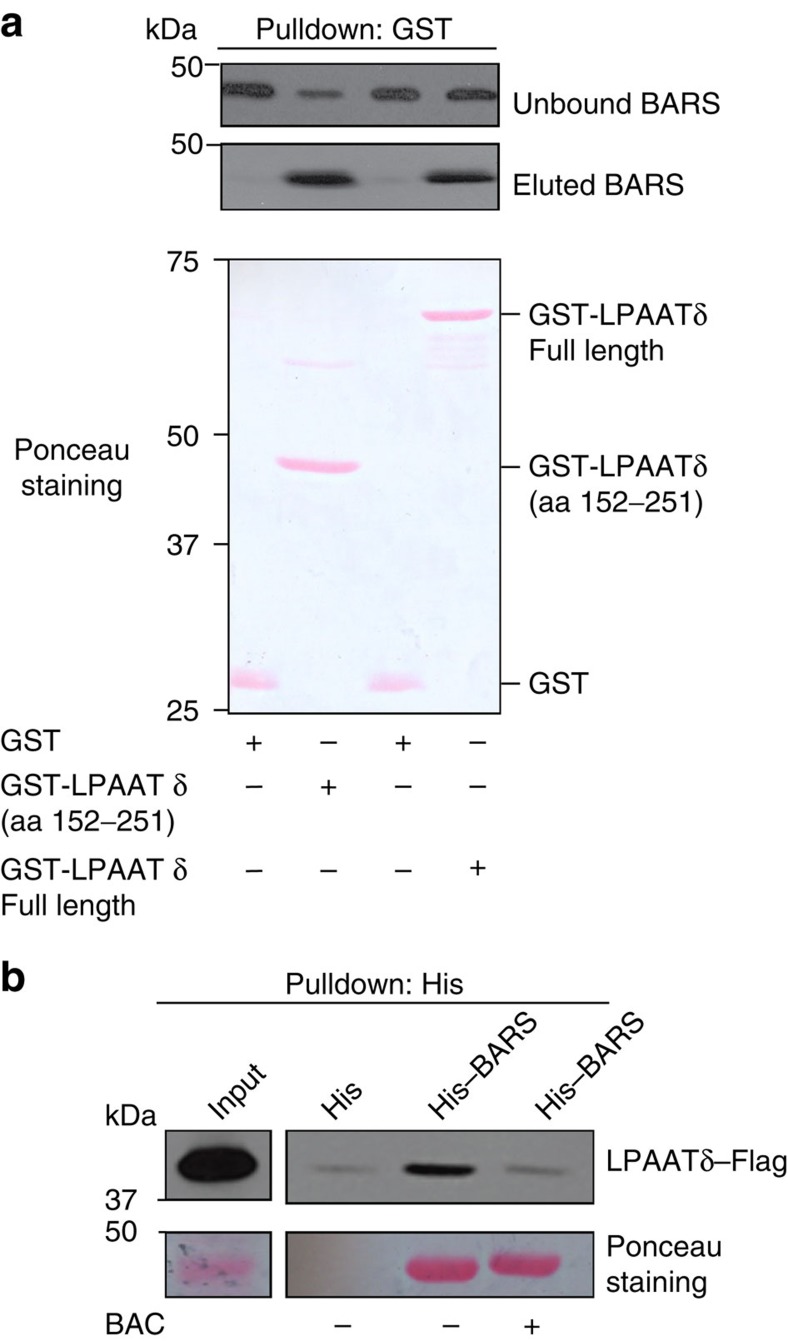
BARS binds LPAATδ directly.(a) Representative GST pull-down of equimolar amounts of GST, GST-LPAATδ (aa 152–251) and GST-LPAATδ (full length) purified recombinant proteins, for His-BARS, with unbound and eluted proteins analysed by western blotting (top, anti-BARS monoclonal antibody). GST fusion proteins were revealed by Ponceau staining (bottom). (b) Representative histidine pull-down for His or His-BARS beads of lysates from COS7 cells transfected with LPAATδ–Flag. Beads were treated with buffer alone (−) or with HPLC-purified BAC (BAC+), and then incubated with the lysates. The eluted proteins were analysed by western blotting using a monoclonal anti-Flag antibody (top), with the pulled down His-BARS revealed by Ponceau staining (bottom). Molecular weight standards (kDa) are indicated on the left of each panel. Data are representative of three independent experiments.